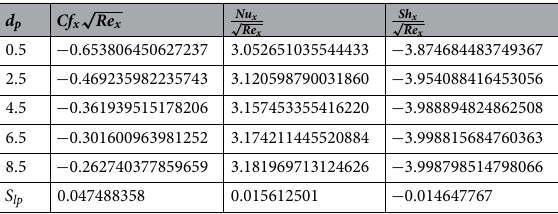
10 and D 100 , S r = ∞ =